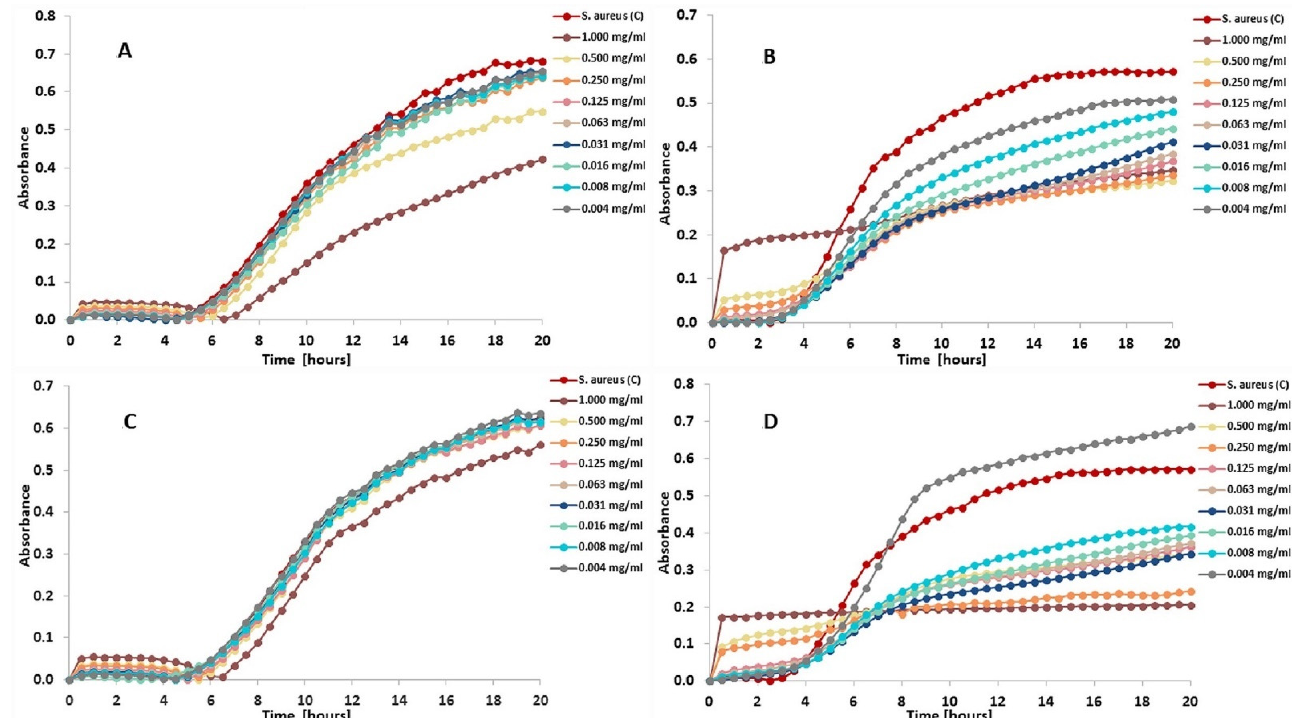
Figure 4. Growth curves of S. aureus with ( A ) Eastern hemlock green cone, ( B ) Eastern hemlock mature cone, ( C ) Norway spruce green cone, ( D ) Norway spruce mature cone extracts.